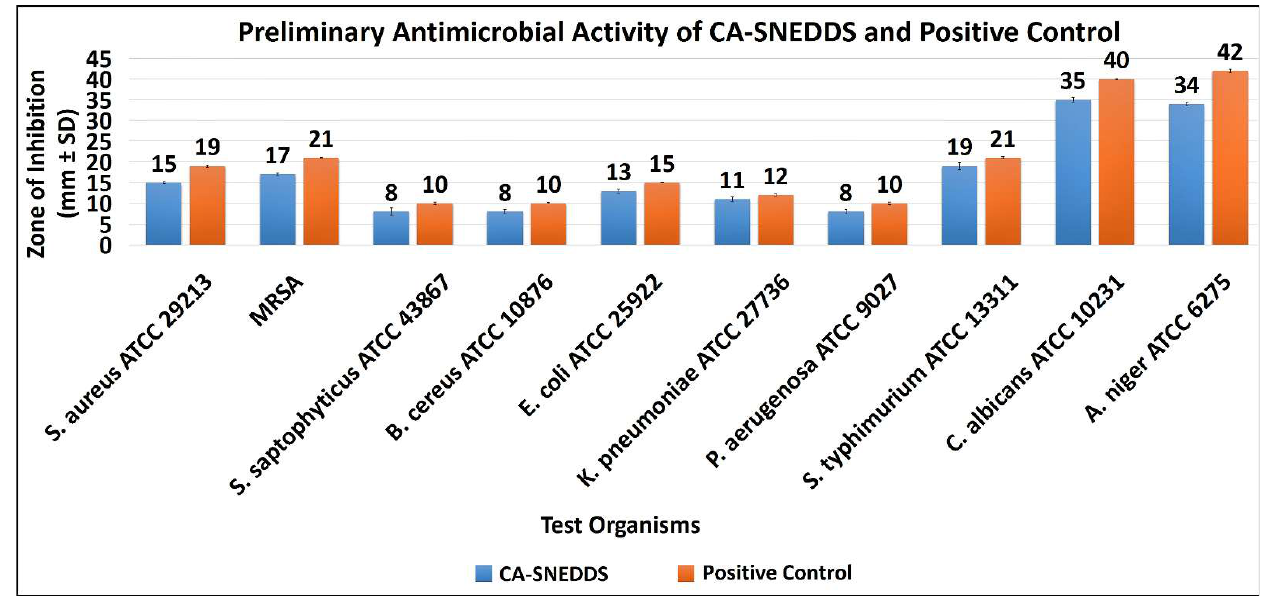
Figure 3. Preliminary antimicrobial activity of CA-SNEDDS. The antibacterial activity of CA-SNEDDS revealed that MRSA and S. typhimurium ATCC 13311 were the most susceptible tested bacteria, with IZD (mm ± standard deviation (SD)) of 17.0 ± 0.3 mm and 19.0 ± 0.9 mm, respectively, at the given dosage of 20 µ L/disc.